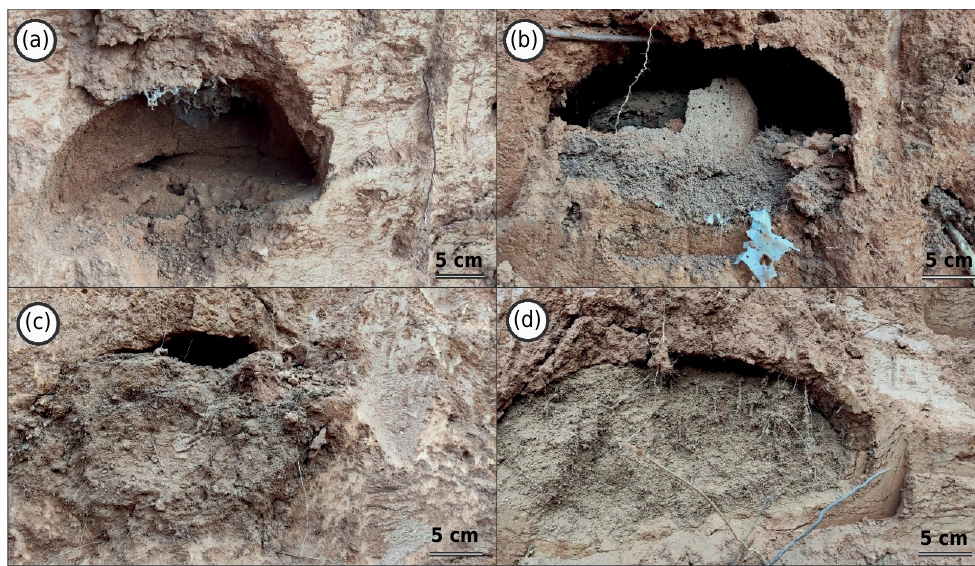
Figure 6. The progressive infilling of a nest chamber with microaggregates (100-300 micrometers in diameter) of Oxisol ( Latossolo ) within a gneiss saprolite from Viçosa,